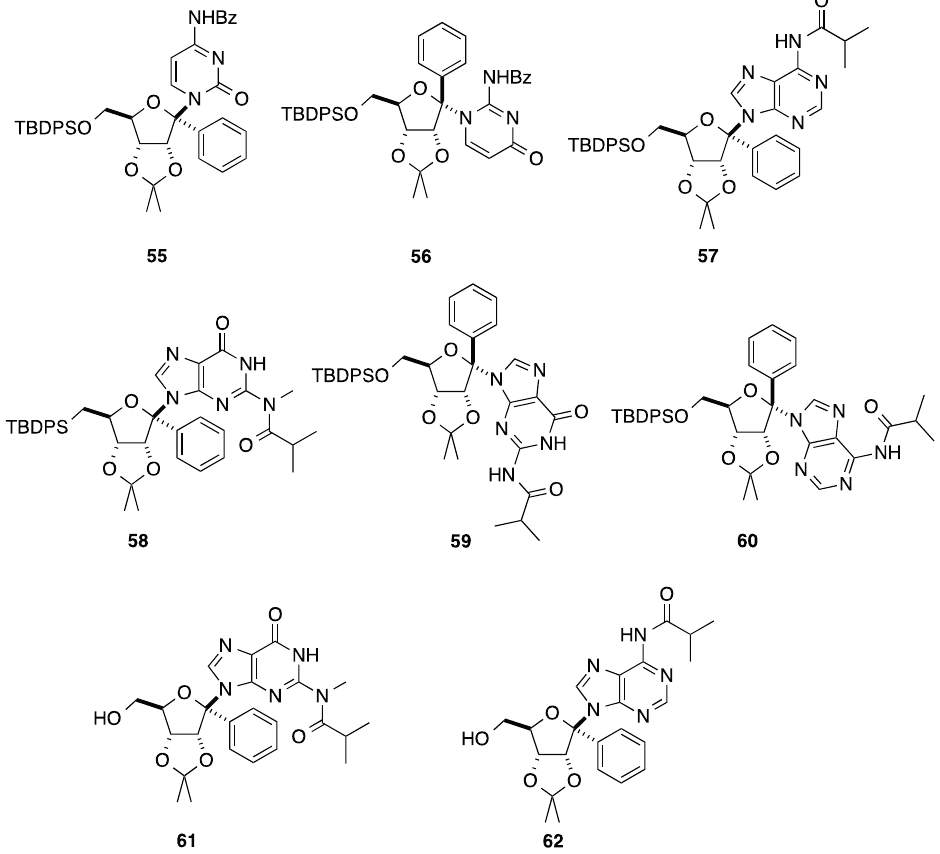
Figure 3. 1'( R )- and 1'( S )- C -phenyl- D -ribofuranosylnucleoside analogues 55 – 62 .